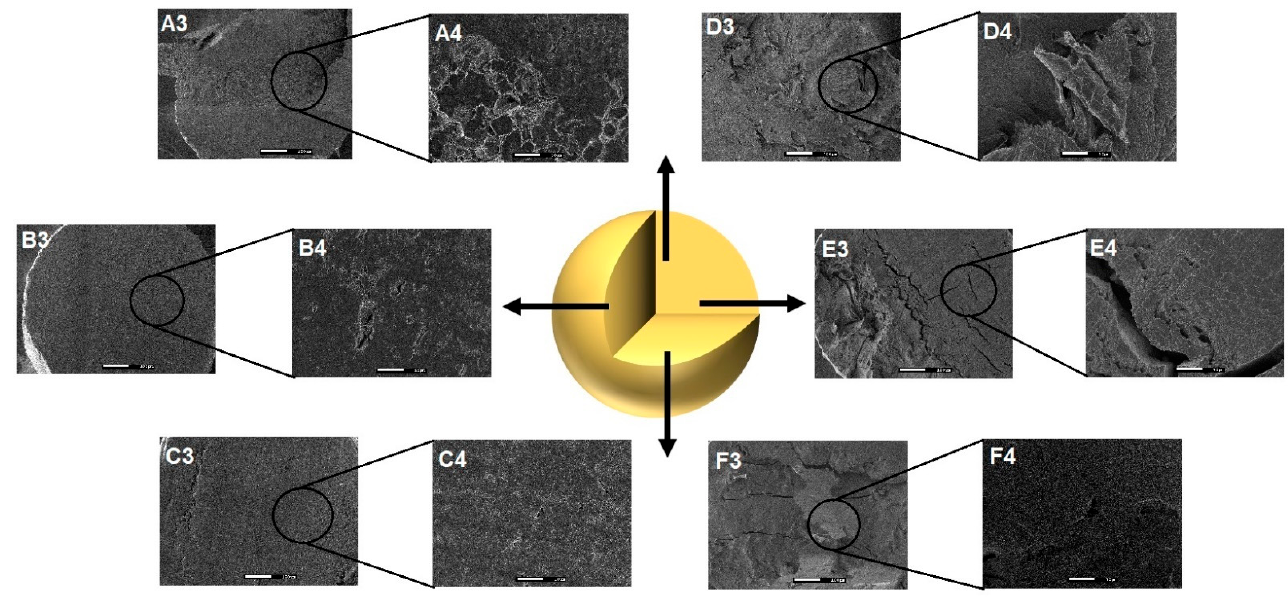
Figure 2. Photomicrographs showing the internal structure of the PMs ( A3 : GRSCa 150×, and A4 : 1500×; B3 : GRSAl 150×, and B4 :1500×; C3 : GRSCaAl 150×, and C4 :1500×; D3 : GPCa 150×, and D4 :1500×; E3 : GPAl 150×, and E4 : 1500×; and F3 : GPCaAl 150×, and F4 : 1500×).